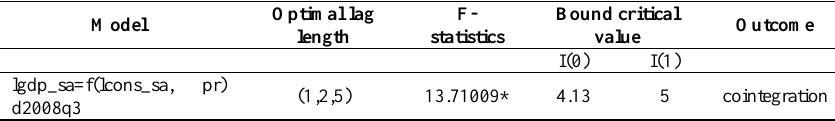
Table 2. The Results of ARDL Cointegration Test